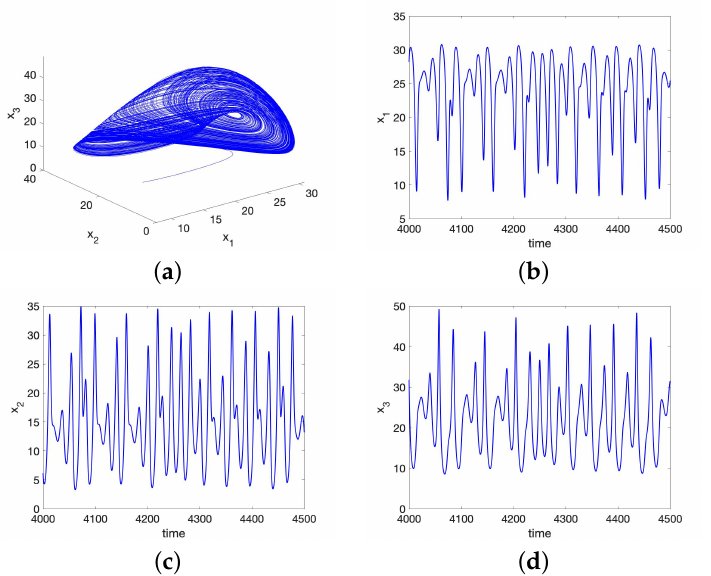
Figure 1. Chaotic dynamics with initial data [ x 1 ( 0 ) , x 2 ( 0 ) , x 3 ( 0 )] = [ 10,10,10 ] in UR model. ( a ) Phase diagram showing chaotic attractor in UR model. ( b ) Time series plot for x 1 . ( c ) Time series plot for x 2 . ( d ) Time series plot for x 3 .